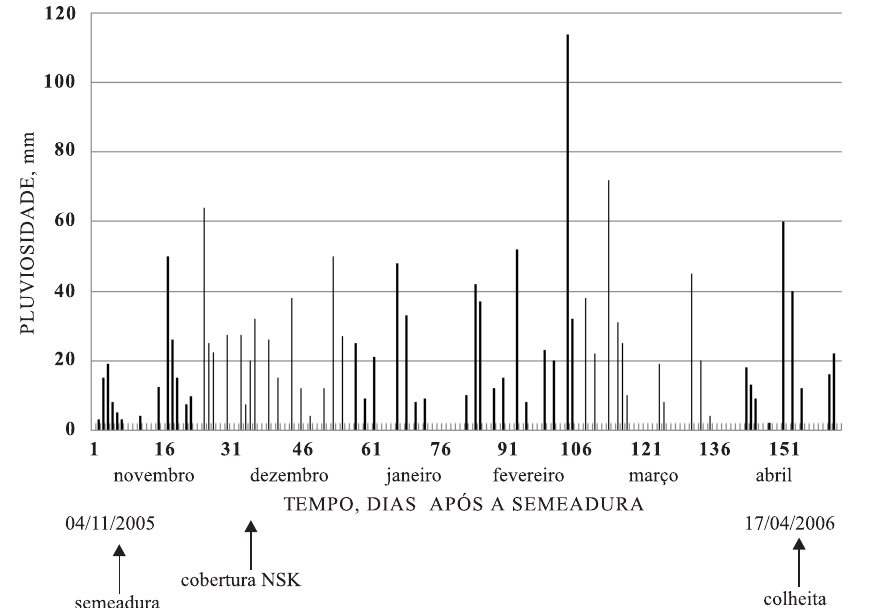
Figura 3. Distribuição da pluviosidade entre os meses de novembro de 2005 até abril de 2006. Uberlândia